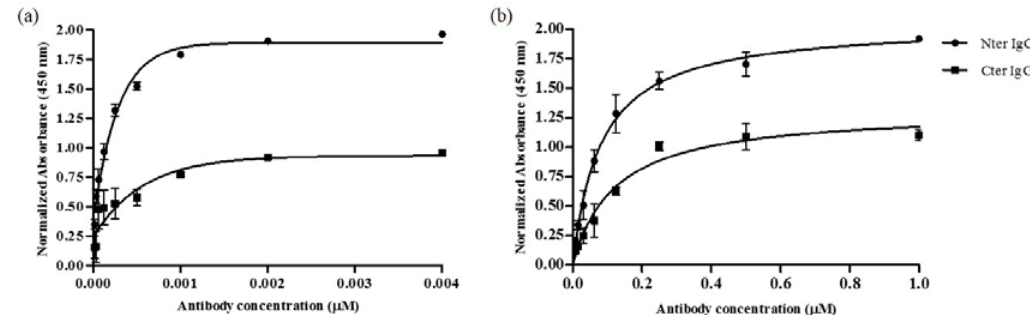
Figure 5. The comparison between the binding of Nter IgG and Cter IgG against ( a ) peptide-BSA conjugates and ( b ) goat α s1 -casein using indirect ELISA.